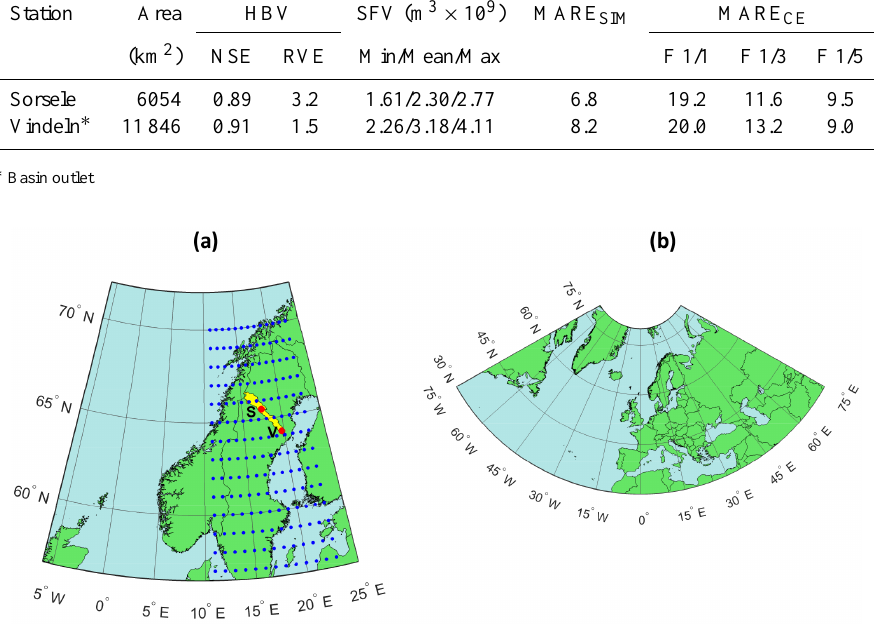
Figure 1. Domain used in the CP method, ECMWF IFS grid (blue dots), Vindelälven catchment (yellow), stations Sorsele (S) and Vin- deln (V) (a) . Domain used in the SD method (b) .